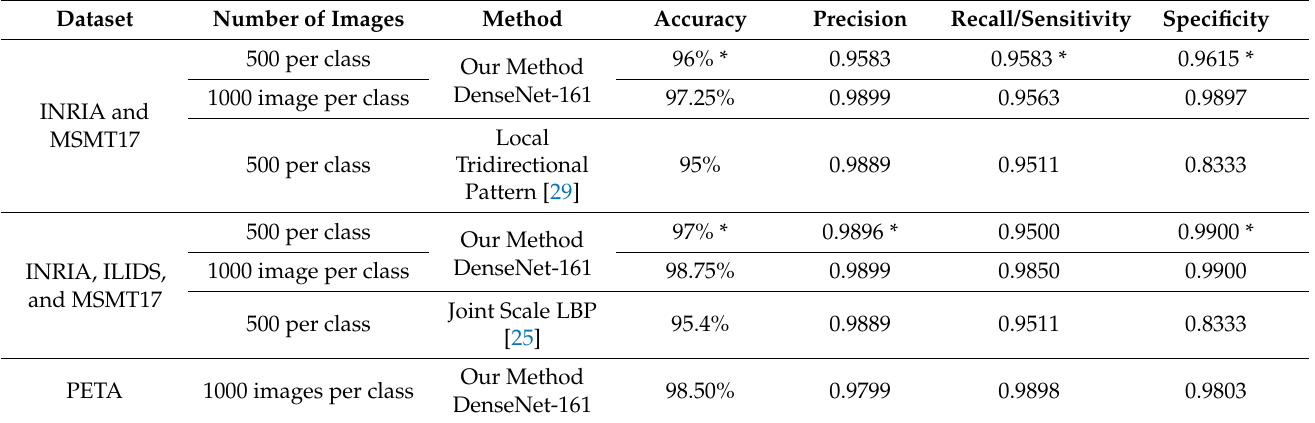
Table 19. Comparison of binary classification.